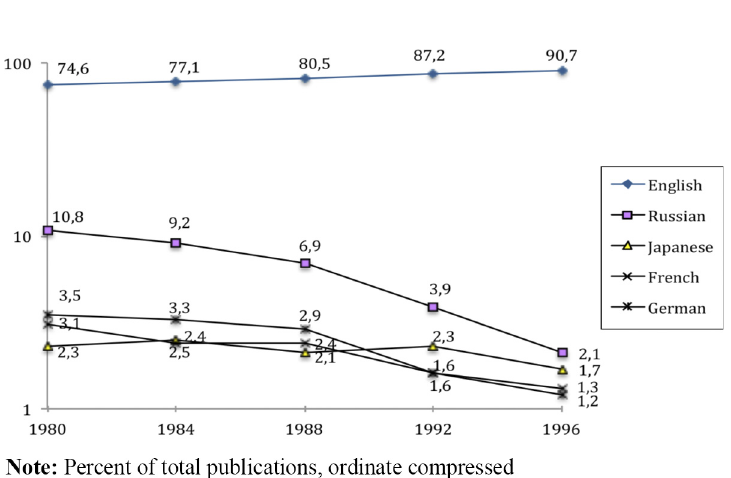
Figure 1. Share of languages in natural